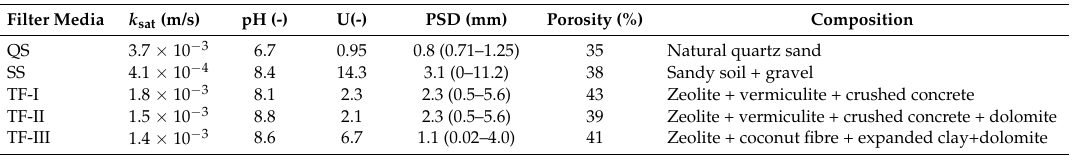
Table 1. Composition and physicochemical properties of filter media used in the